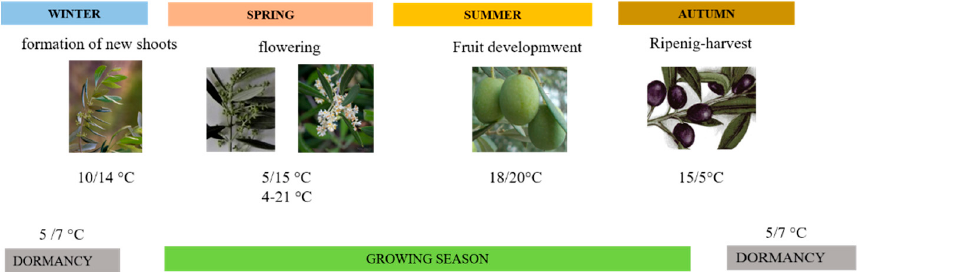
Figure 1. Temperature ranges for the species in relation to the thermal requirements of the various phenological phases according to the BBCH scale.